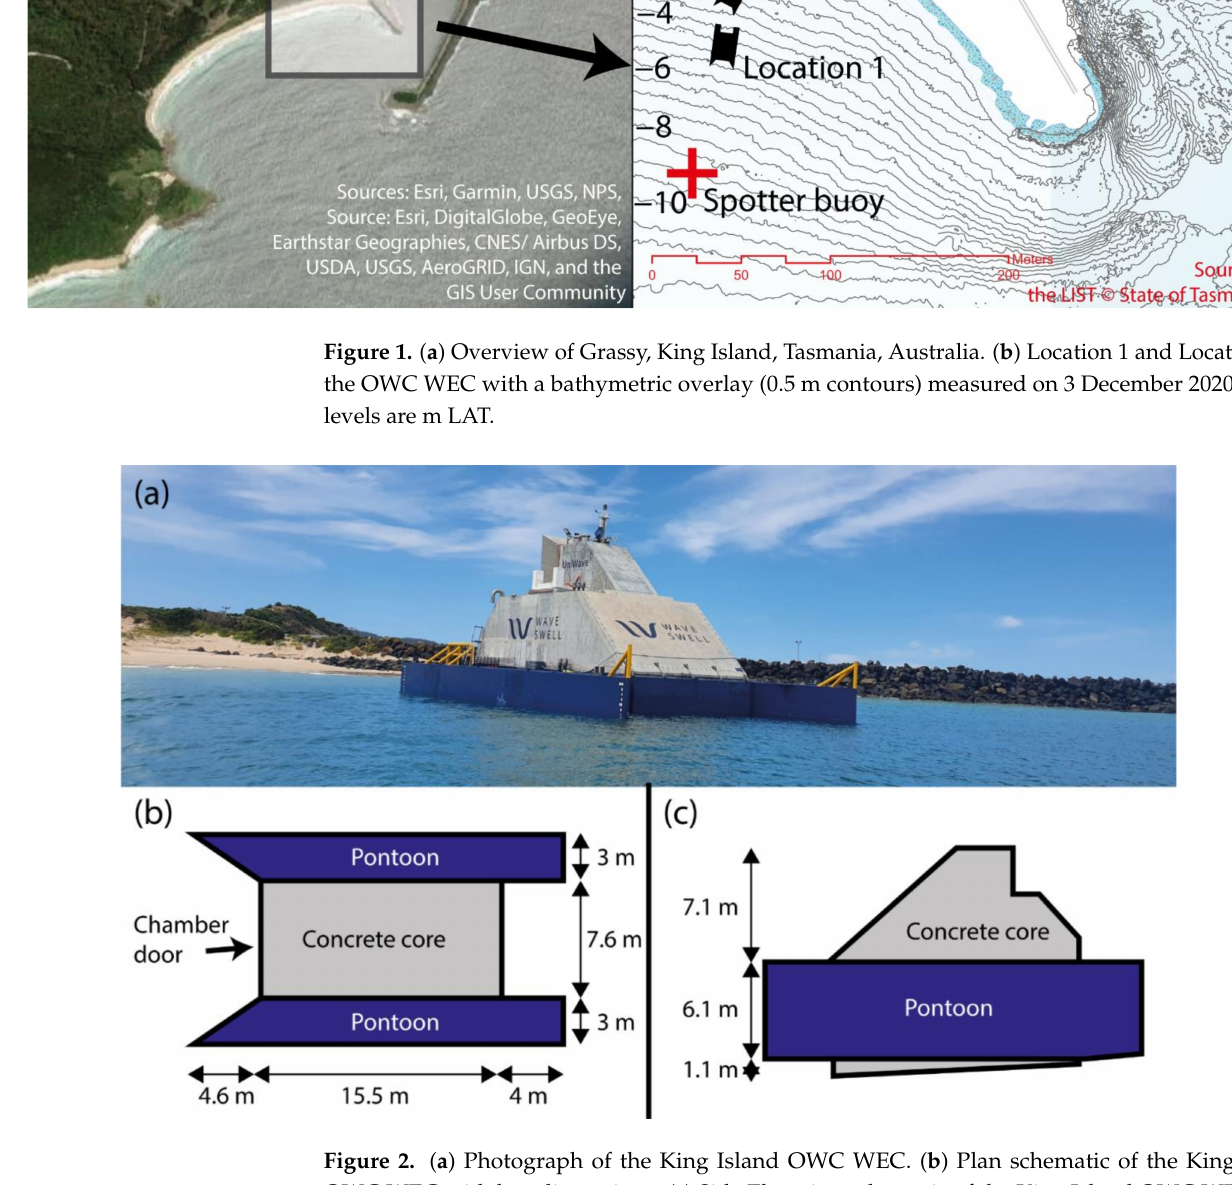
Figure 2. ( a ) Photograph of the King Island OWC WEC. ( b ) Plan schematic of the King Island OWC WEC with key dimensions. ( c ) Side Elevation schematic of the King Island OWC WEC with key